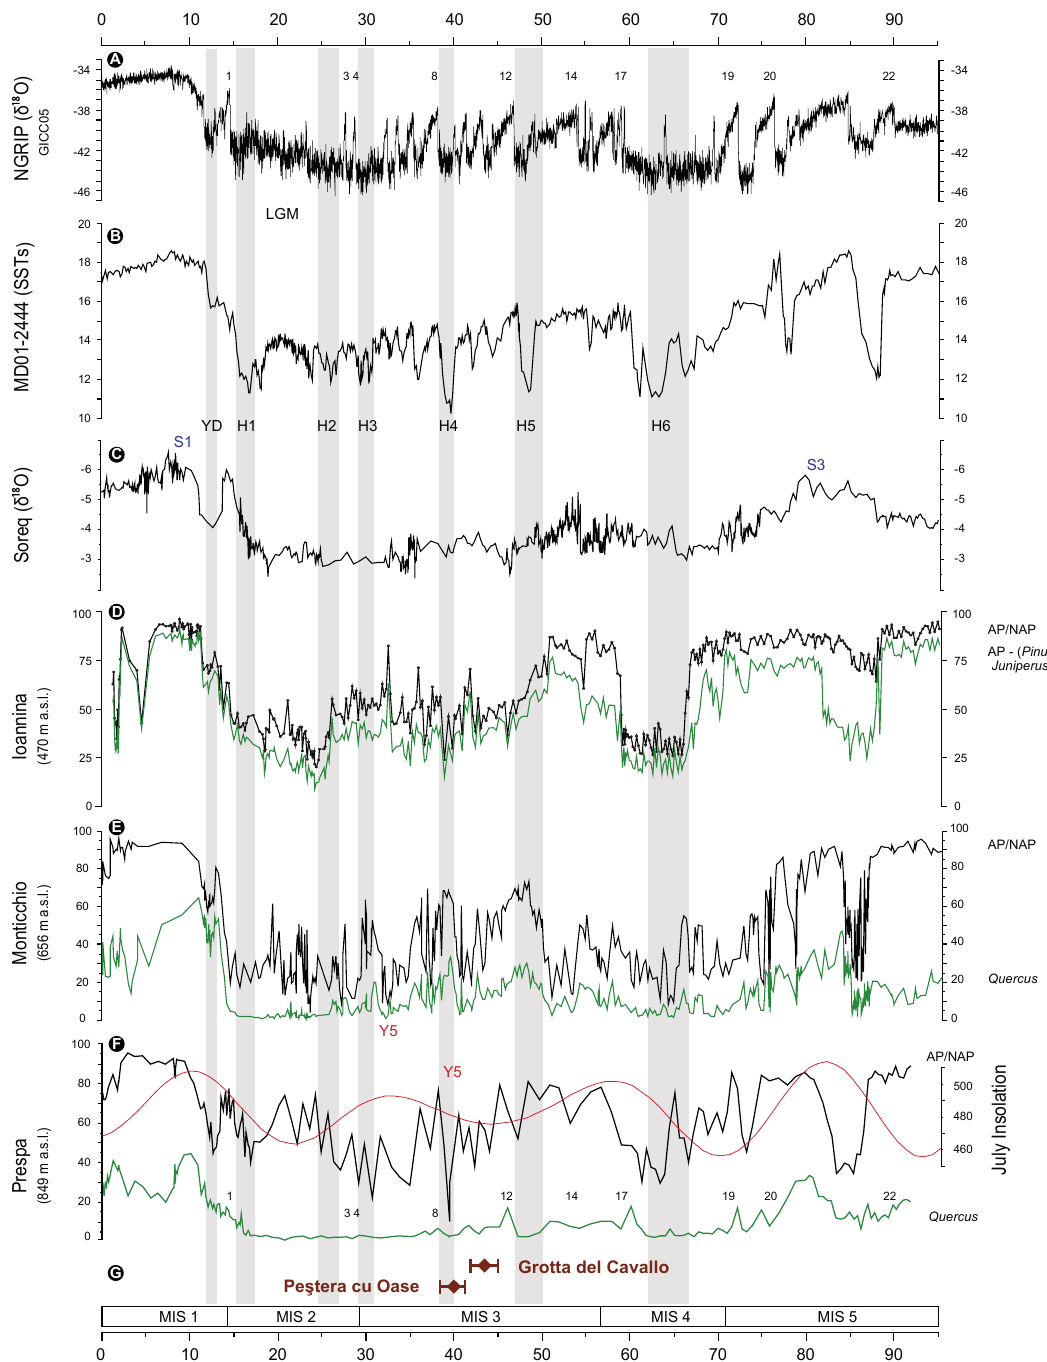
Fig. 6. Comparison of Prespa proxies with regional and global records. (A) Ice core oxygen isotopes (‰) measured in NGRIP (GICC05 modelext) with Dansgaard–Oeschger (D–O) warming events/Greenland interstadials (GI) numbered; Last Glacial Maximum is indicated; 0 (B) alkenone derived (U k ) sea surface temperatures (SSTs) measured in core MD01-2444 from the Atlantic Ocean; (C) oxygen isotopes 37 (‰) measured in speleothems from Soreq Cave (Israel) and sapropel depositions (S1, S2) in the eastern Mediterranean Sea; (D) AP / NAP (black) and AP minus Pinus and Juniperus (green) pollen percentages in I-284 from Lake Ioannina (Greece); (E) AP / NAP (black) and Quercus (green) pollen percentages from Lago Grande di Monticchio (Italy); (F) AP / NAP (black) and Quercus (green) pollen percentages from Lake Prespa, mean July insolation at 40 ◦ N (Wm − 2 ; red); (G) calibrated radiocarbon ages from neighboring sites with modern human remains. Gray bars correspond to Heinrich events in